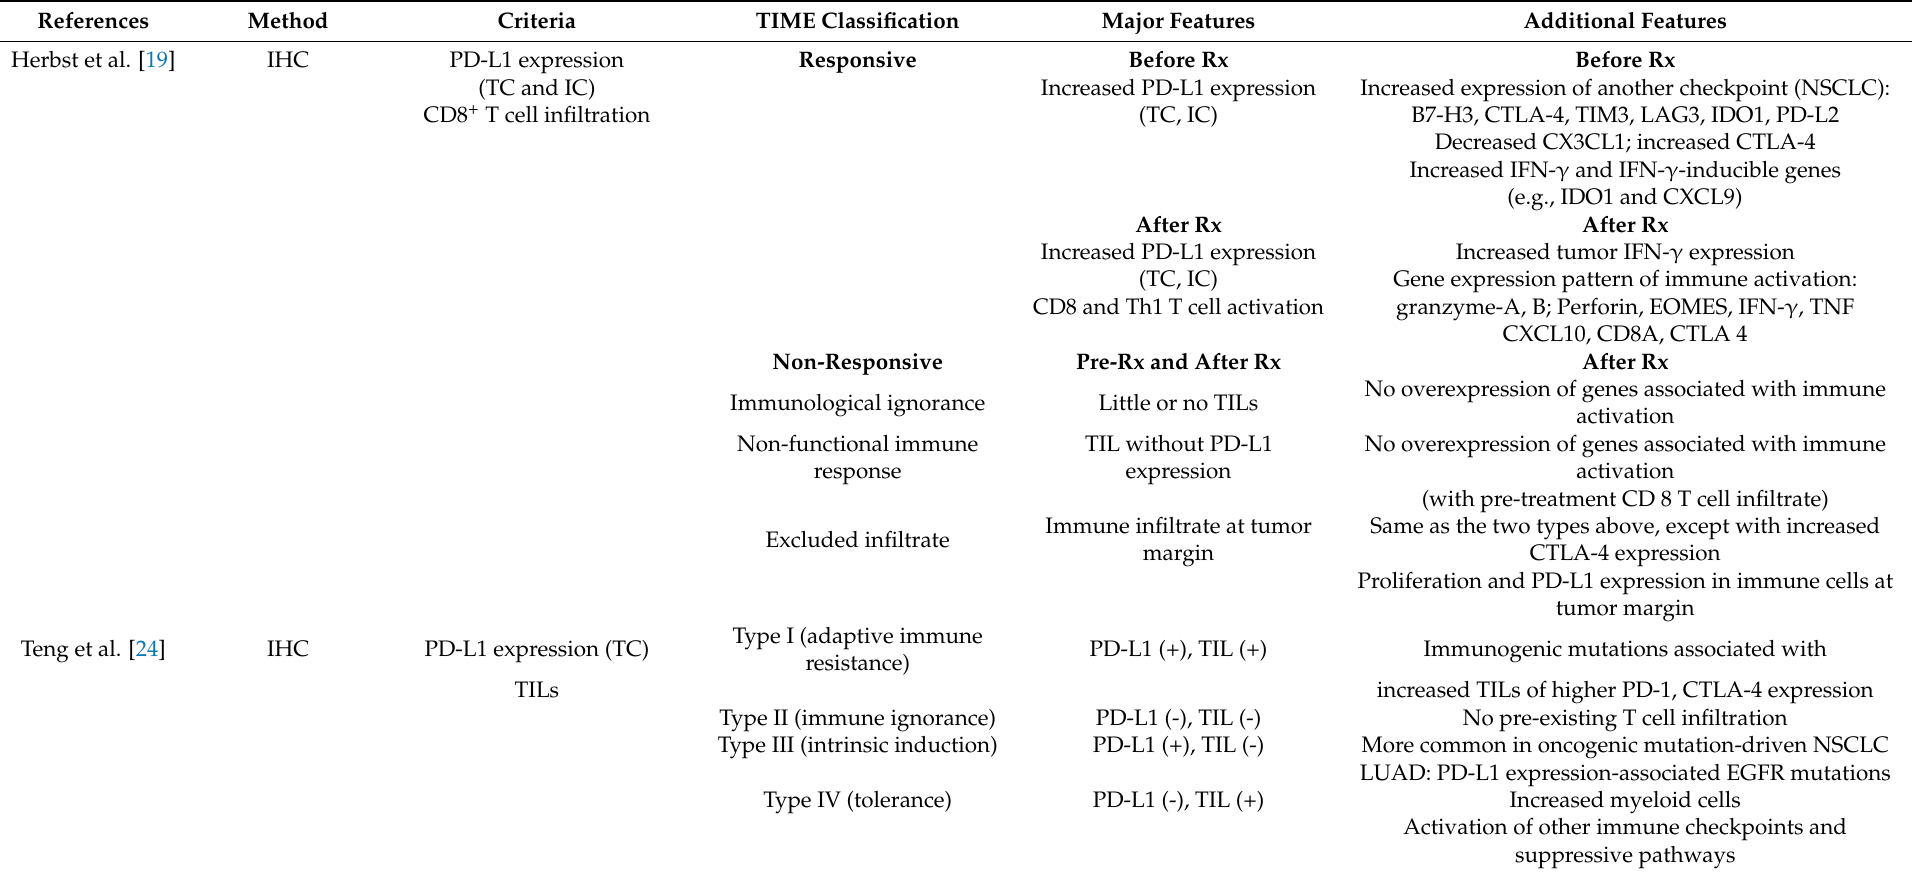
Table 1. General classification of the tumor immune